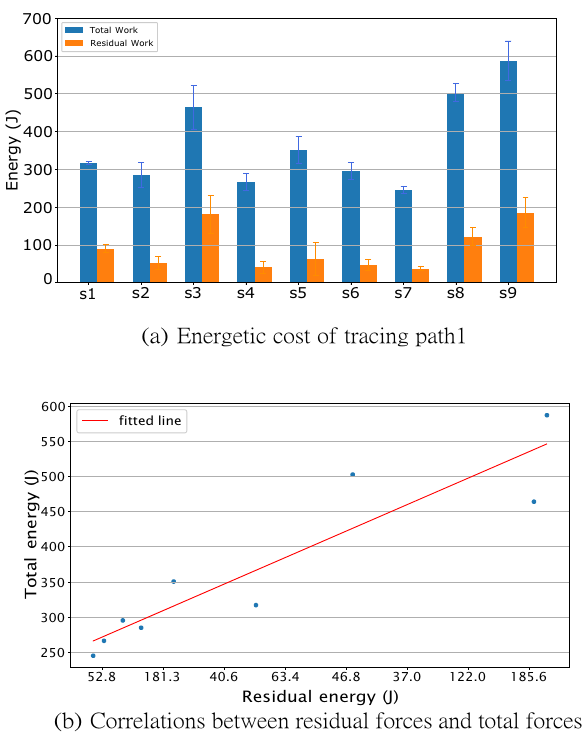
Figure 3. Energetic costs of tracing path 1. ( a ) Each subject traced path 1. with five repeats. The horizontal labels indicate the related subjects, e.g., “S1” represents the subject1. The total cost is shown in blue, and the portion of that cost due to residual forces are shown in orange. A low cost in residual torque usually signifies that the dynamic model is a good match for that subject’s kinematic data. ( b ) The residual is highly correlated with the overall cost (R=0.922), suggesting that the differences in both values reflect differences in the body models.